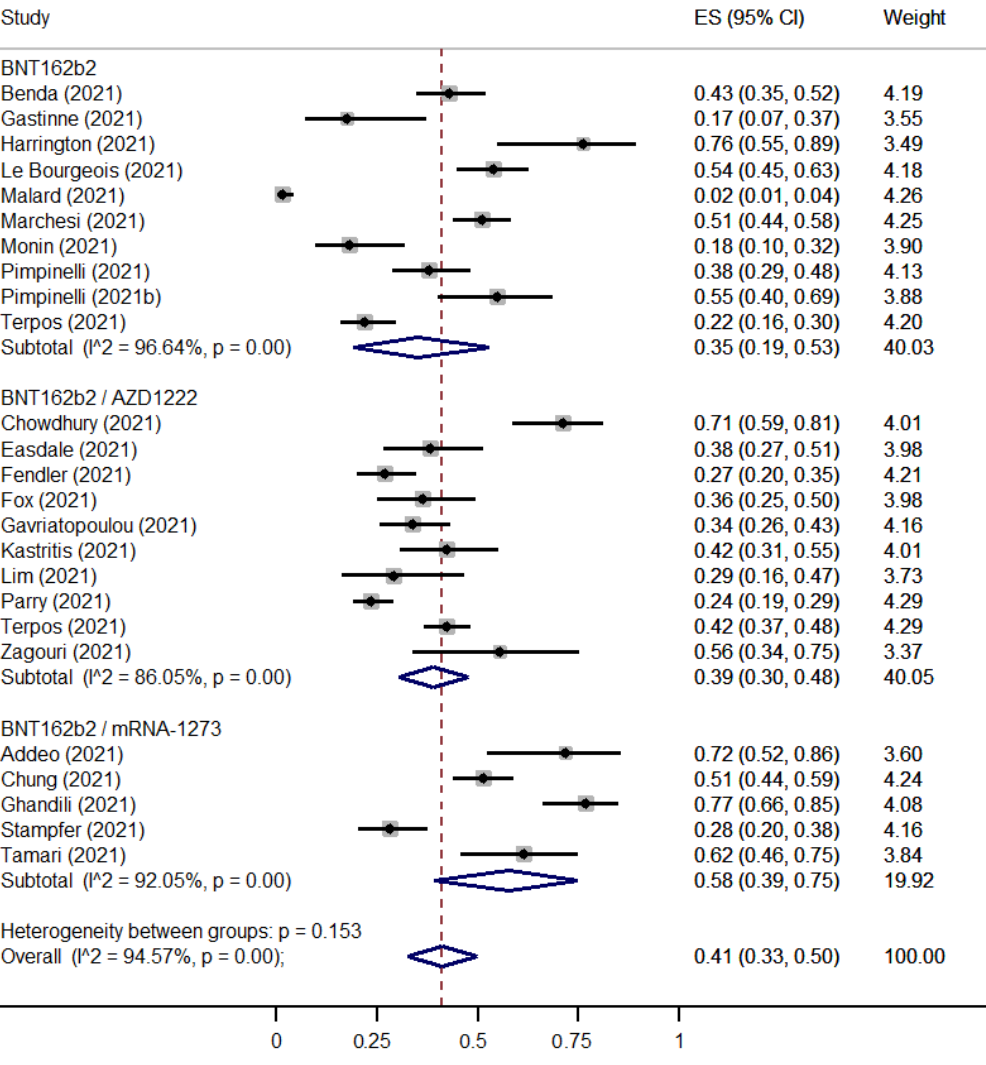
Figure 2. Pooled EffectSize (ES) for the immune seroconversion rates of patients with hematological malignancies after the first dose of COVID-19 vaccine.